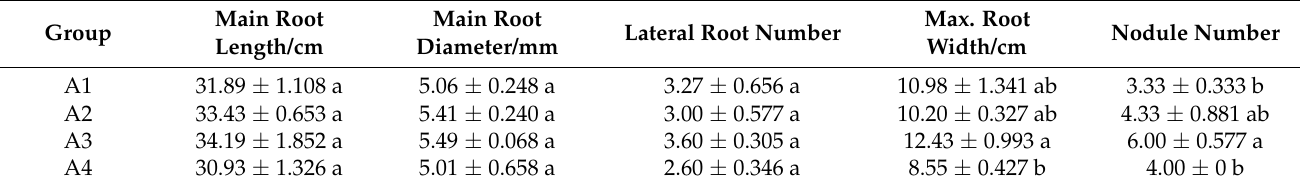
Table 2. Root system